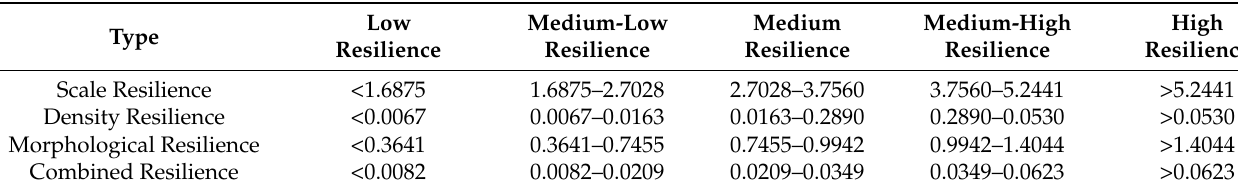
Table 4. Classification criteria of resilience level in the study area.